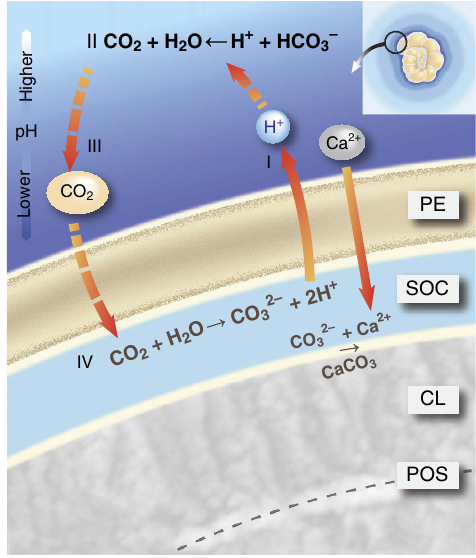
Figure 3 | Proton pumping-based model of foraminiferal calcification. During calcification of a new calcitic layer (CL) on a primary organic sheet (POS), the protective envelope (PE) separates the growing calcite surface from the surrounding seawater. The chemical composition at the SOC, created by the PE, is characterized by active, outward proton pumping (I). The reduced pH in the foraminiferal microenvironment shifts the inorganic carbon speciation (II), thereby increasing p CO 2 directly outside the PE. The large gradient in p CO 2 across the PE results in diffusion of CO 2 into the SOC (III). Once inside, the CO 2 reacts to form CO 3 2 (cid:2) due to the high pH (IV) sustaining CaCO 3 precipitation by reacting with the Ca 2 þ . The reduction in pH is seen over the entire foraminifer (inset), suggesting that this model applies to the complete surface of the shell of a rotalid foraminifer producing a new